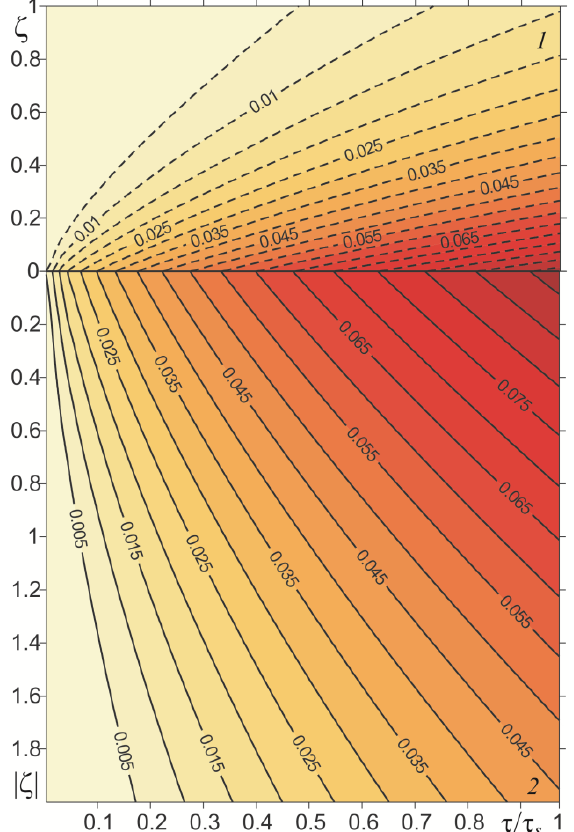
Figure 4. Isotherms of dimensionless temperature rise Θ ∗ ( ζ , τ ) during sliding with constant velocity: cast iron ( 1 )—solid lines; FGM ( 2 )—dashed lines.